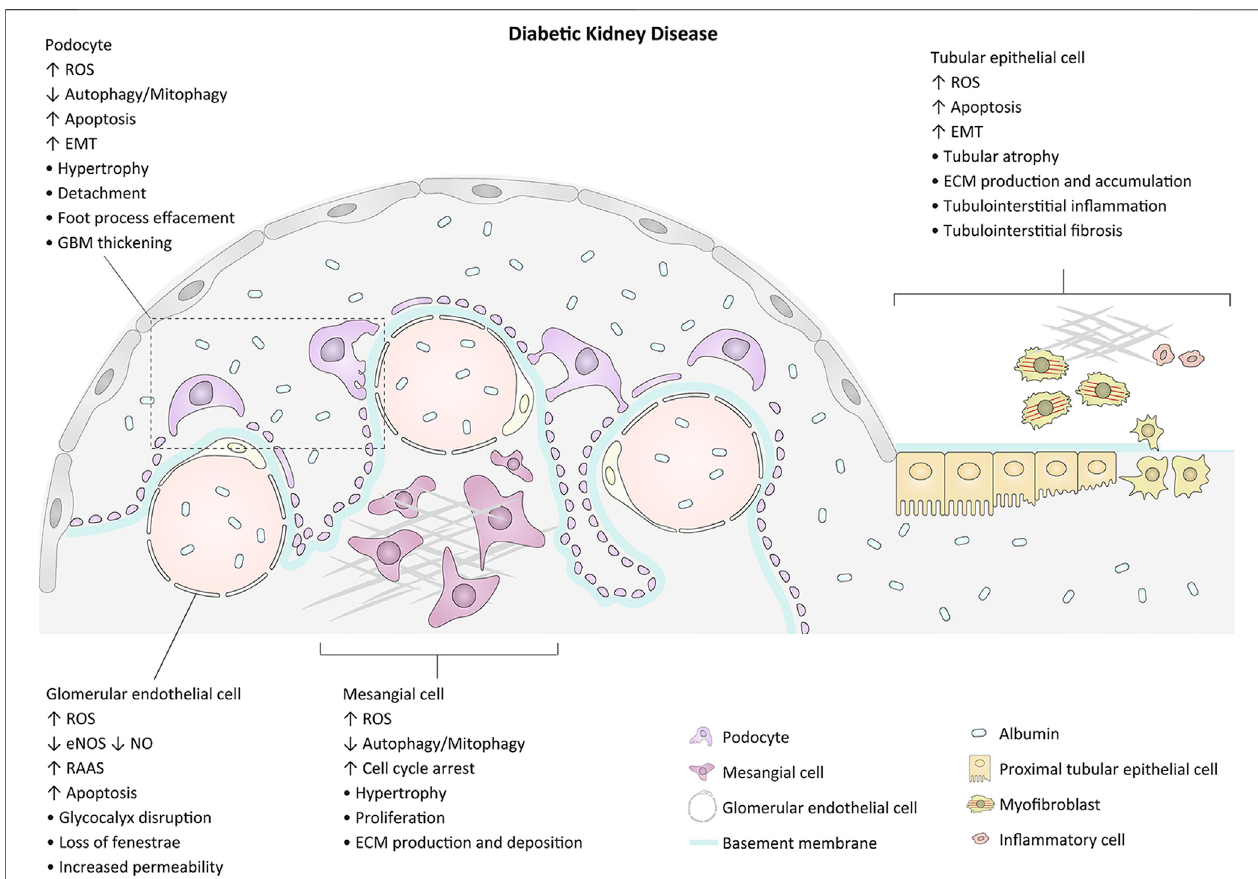
FIGURE 1 | Major events and morphological changes related to the pathogenesis of glomerulopathy and tubulointerstitial lesion in diabetes. GBM, glomerular basement membrane; EMT, epithelial-mesenchymal cell transformation; ROS, reactive oxygen species; ECM, extracellular matrix.